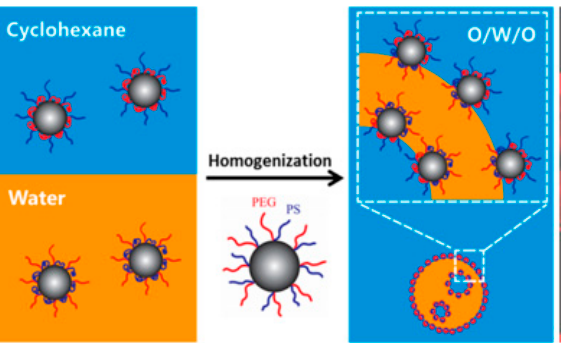
Figure 3. Schematic Illustration of stabilization mechanism of the environmentally responsive terpolymer grafted silica colloidal particles. Reprinted with permission from [11].